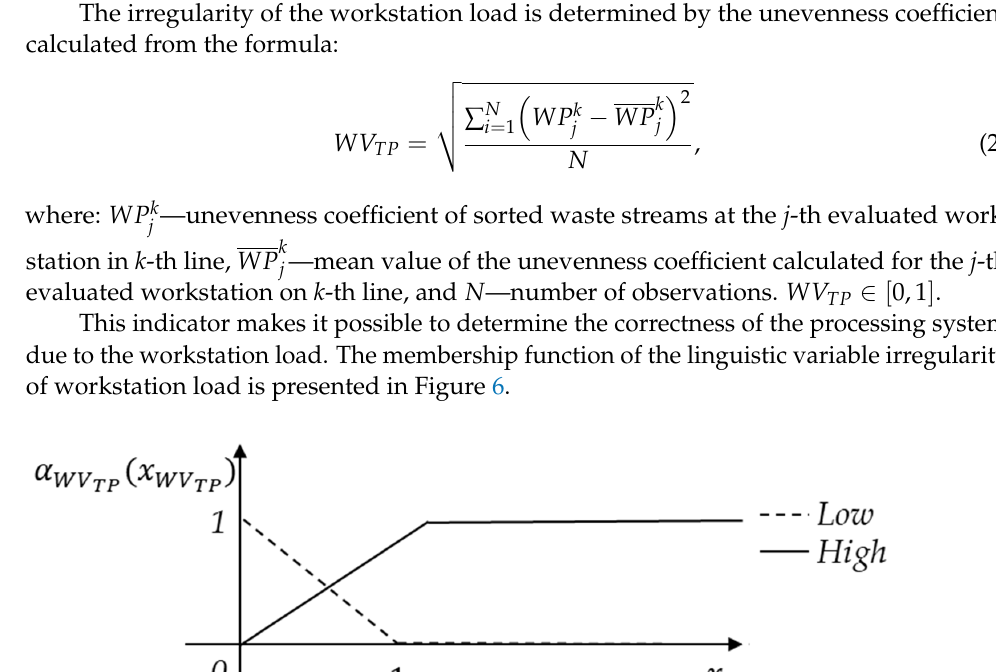
Figure 5. The membership function of the linguistic variable in the effectiveness of the processing system.